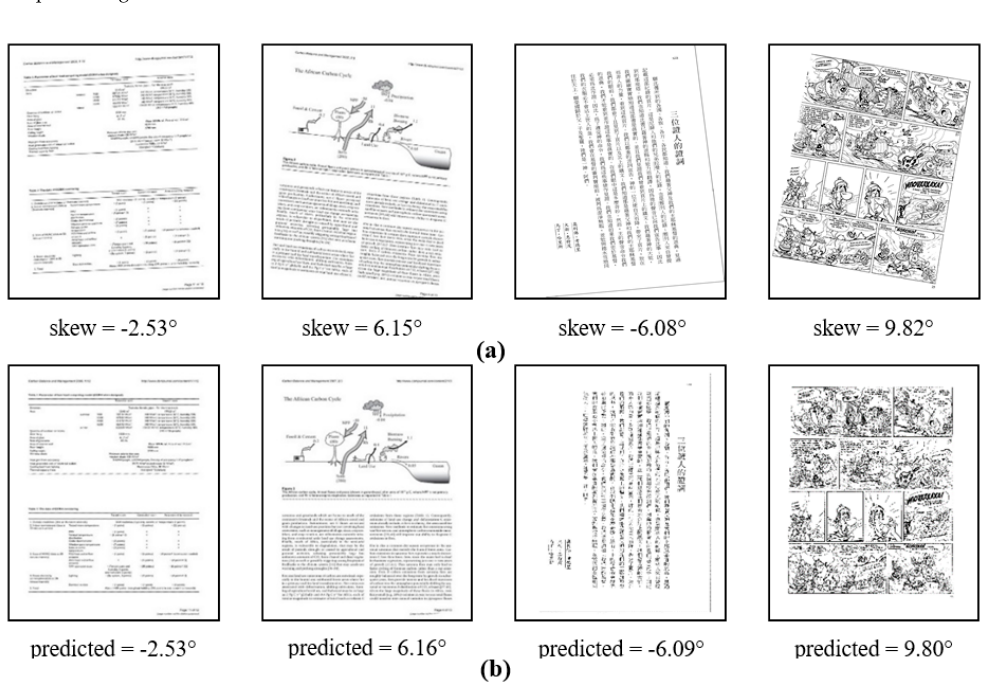
1 Top three algorithms of DISEC 2013.